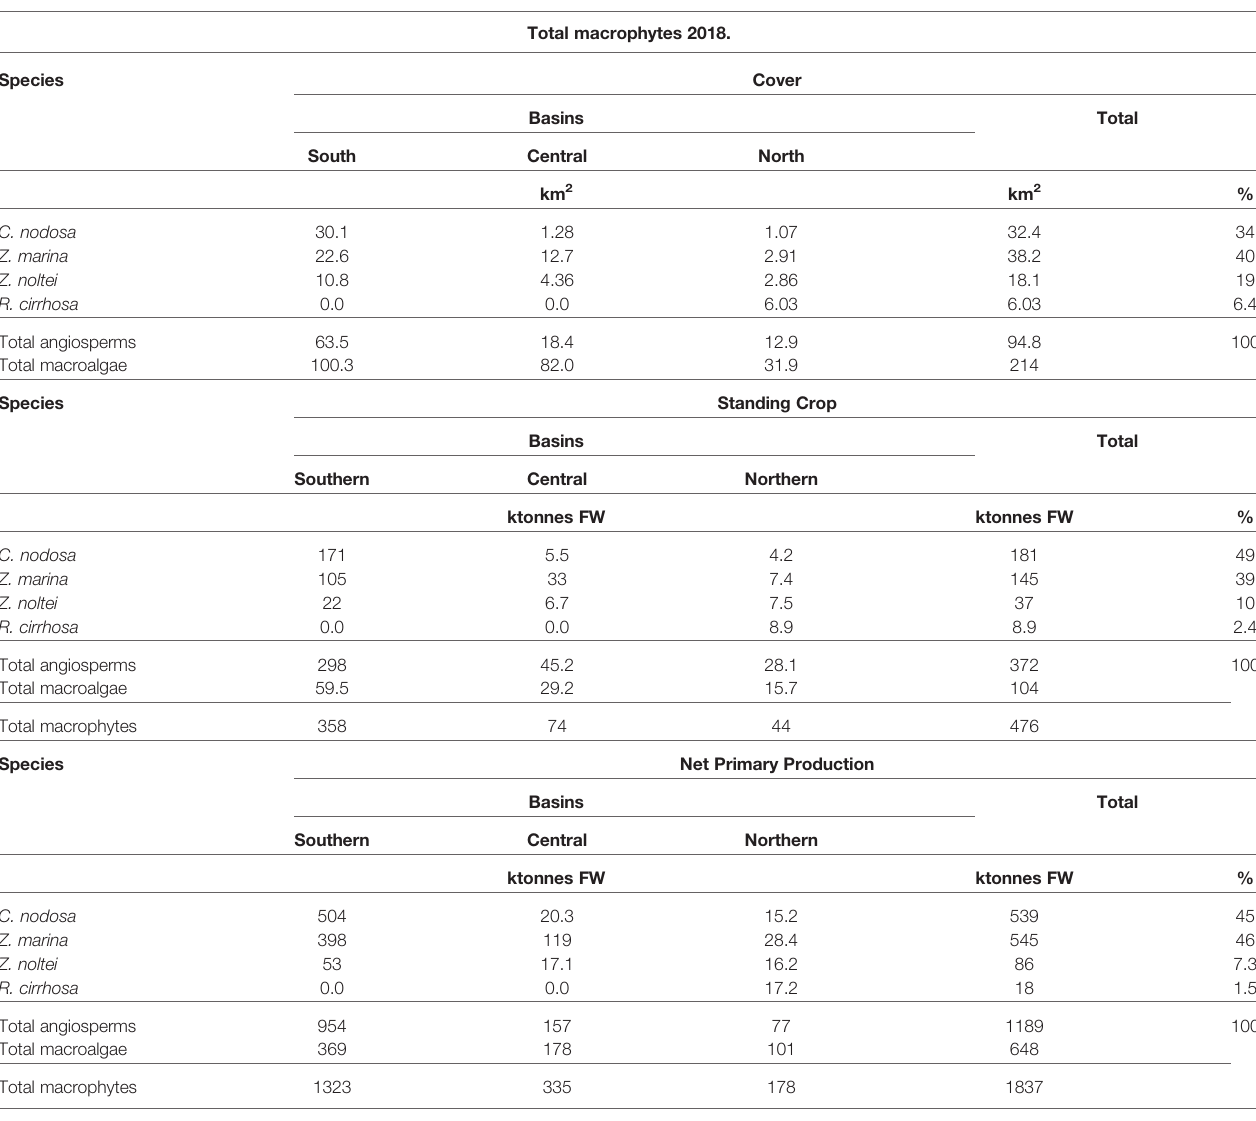
TABLE 3 | Macrophyte cover, SC and NPP .